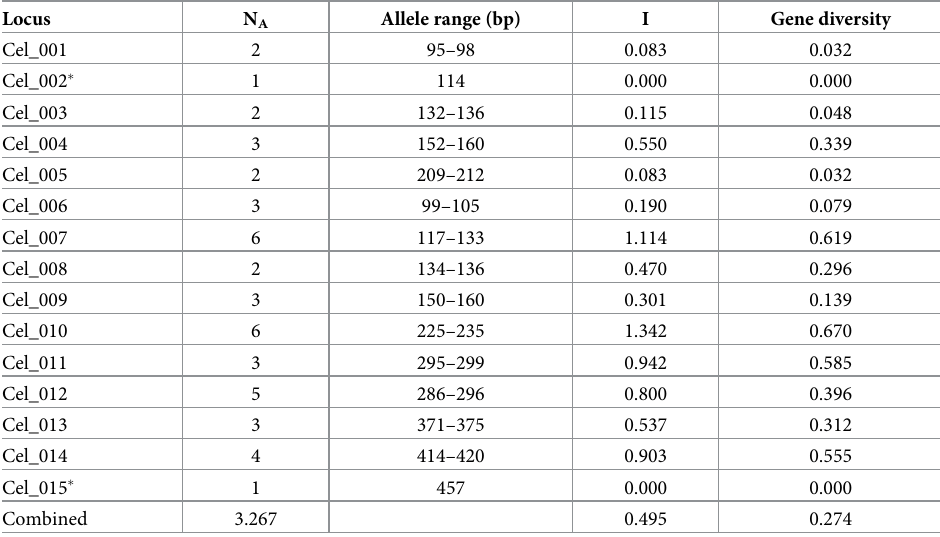
lines, and 11 of 72 X haplotypes were shared between sites.